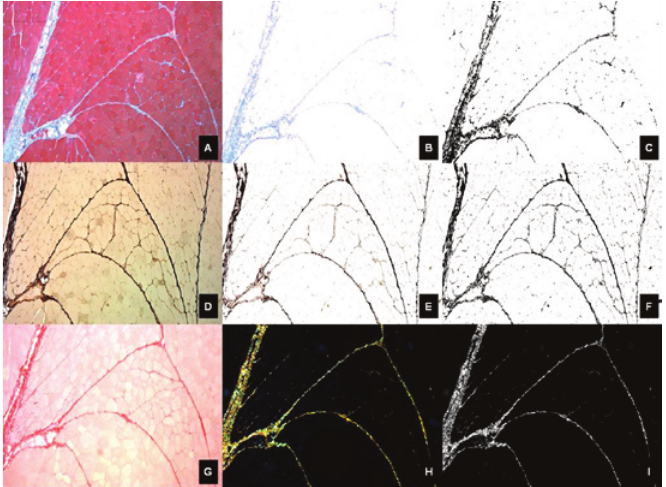
FIGURE 4 – Micrographs of histological sections of the rectus abdominis muscle stained with ( A-C ) Masson’s trichrome; ( D-F ) reticulin; and ( G-H ) picrosirius red. Fields selected in ( B, E ) Corel PhotoPaint, ( H ) examined by polarized light microscopy, and ( C, F, I ) exported to the Image Toll software for quantification of collagen fibers. Magnification